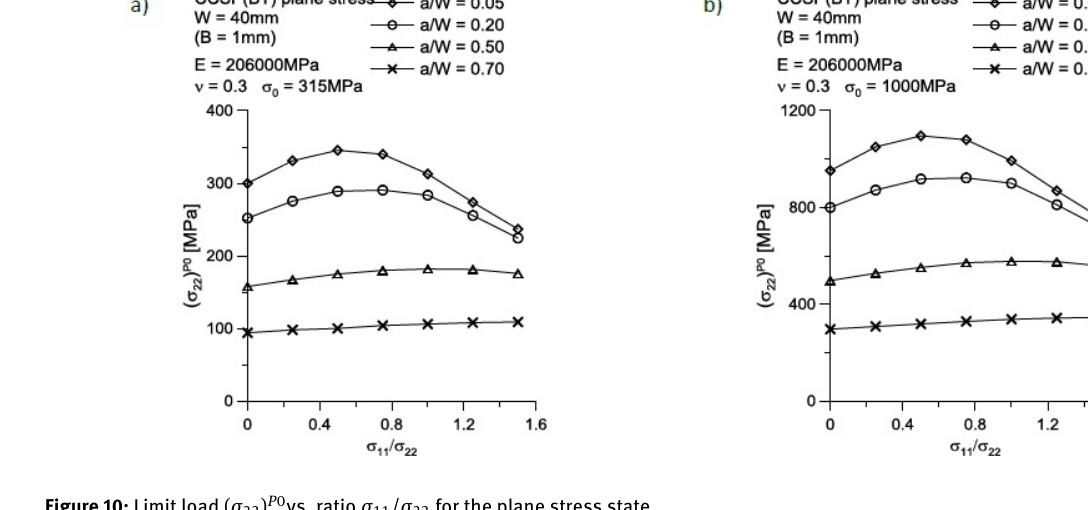
Figure 10: Limit load ( σ 22 ) P 0 vs. ratio σ 11 / σ 22 for the plane stress state.